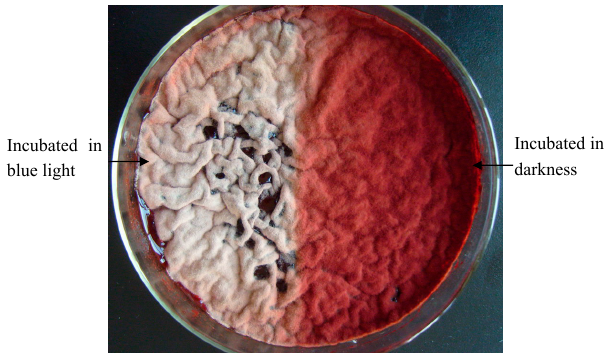
Figure 1. Effect of blue light on Monascus culture morphology in liquid fermentation. Left part and right part of the culture dish were separately exposed to either blue light or protected by tinfoil paper for 5 days.